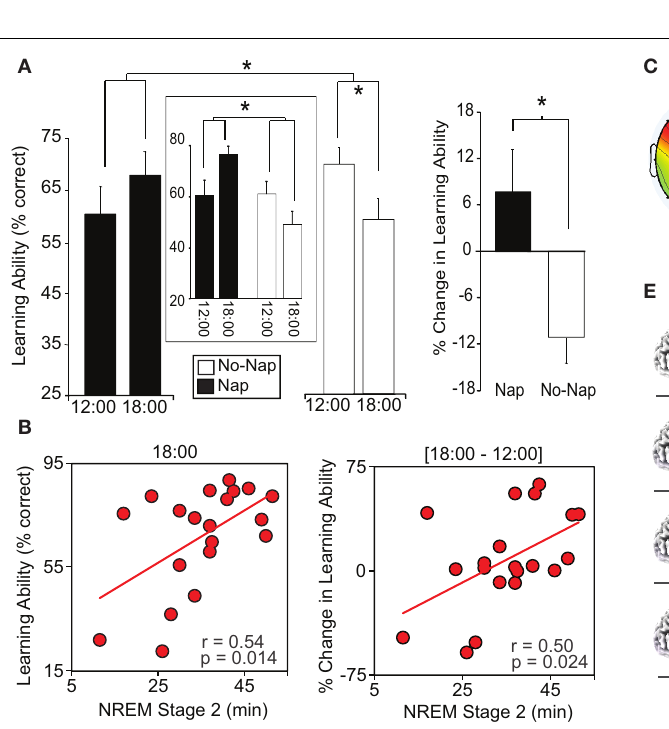
FIGURE 2 | Sleep deprivation and encoding of emotional and non-emotional declarative memory. Effects of 38h of total sleep deprivation on encoding of human declarative memory (A) when combined across all emotional and non-emotional categories; (B) When separated by emotional (positive and negative valence) and non-emotional